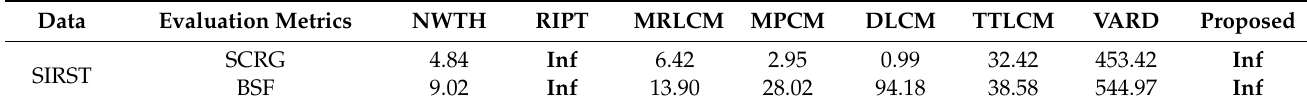
Table 3. The statistics of SCRG and BSF of different